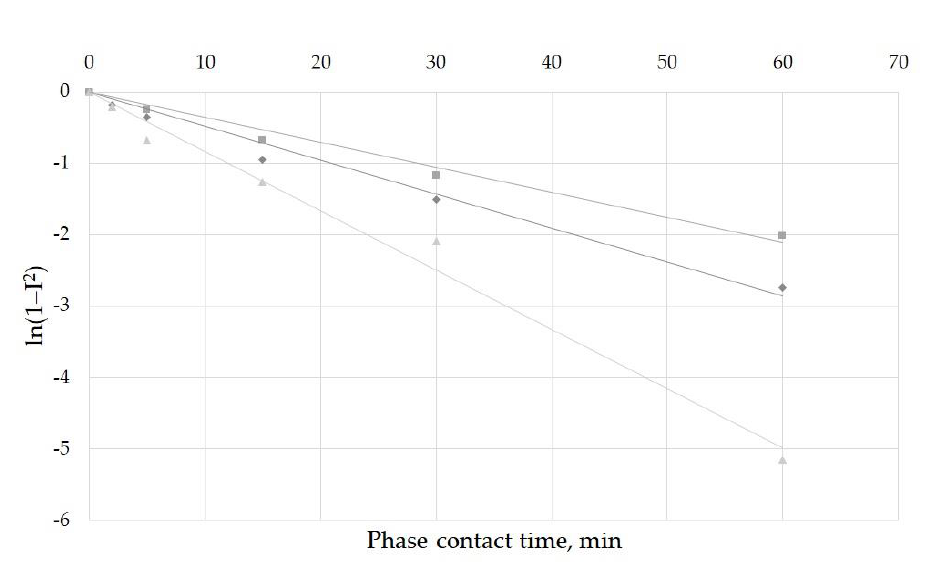
(cid:16) (cid:17) Figure 14. The dependences ln 1 − I 2 of yttrium extraction on the phase contact time under temperatures   2 ln 1 I  Figure 14. The dependences of yttrium extraction on the phase contact time under of 295, 313, and 333 K. temperatures of 295, 313, and 333 К. Table 4. Extraction and approximation coe ffi Table 4. Extraction and approximation coefficients.